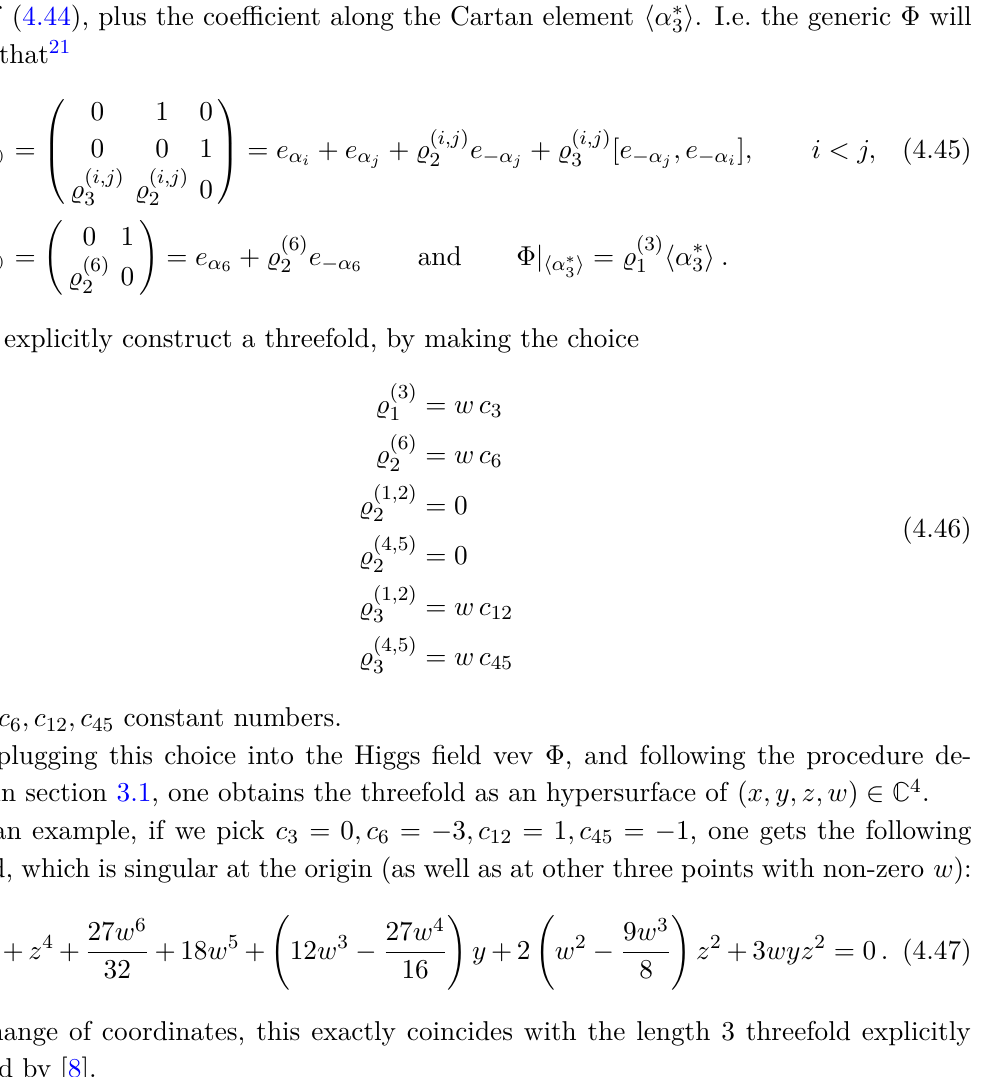
i . I.e. the generic Φ will 3